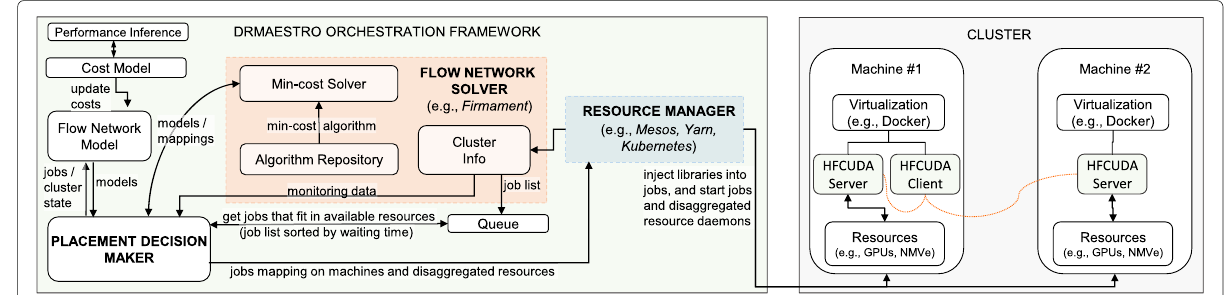
Fig. 1 Conceptual view of DRMaestro’s architecture. In a loop-based approach, the Resource manager (e.g., Kubernetes [10]) appends to the queue the new incoming jobs. If there are enough resources in the cluster, a list of jobs is sent to the Flow Network Model module to update the models. The optimal placement is determined by sending the updated models to the Flow Network Solver Model (e.g., Firmament [13]). If necessary,